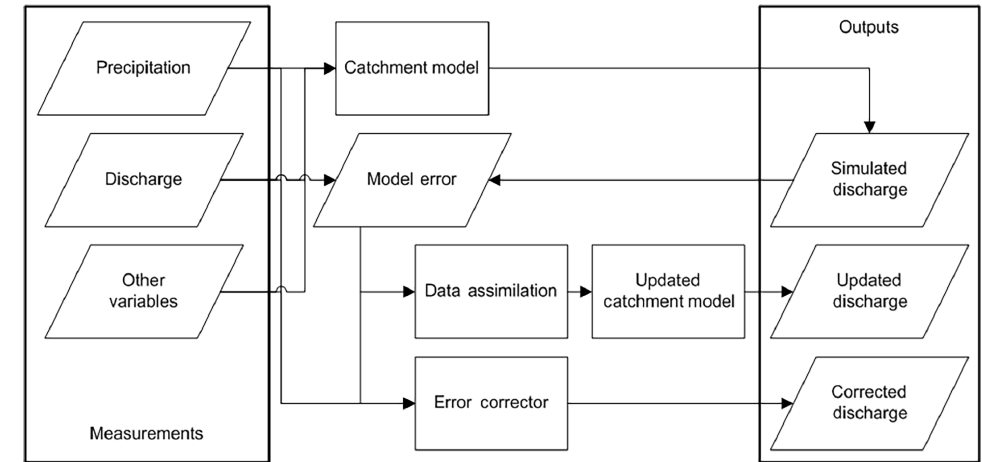
Figure 1. Typical data flow in discharge simulation using hydrological models.